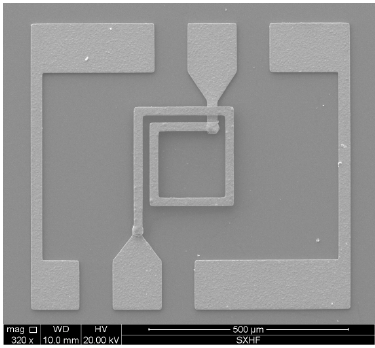
Figure 7. SEM image of the fabricated MEMS suspended inductor.